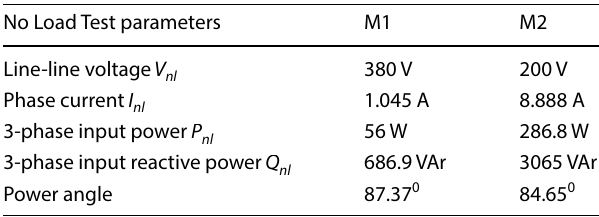
Table 4 No-load test simulation